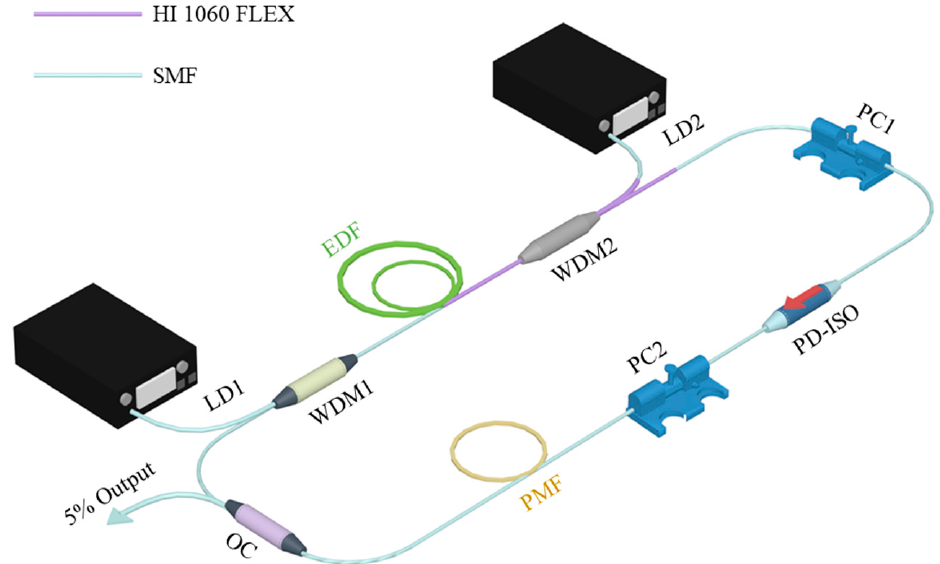
Figure 1. Experimental setup of HRR erbium-doped fiber laser. Due to the existence of PD-ISO and PMF, a wavelength-dependent birefringence- induced filter with a comb transmission spectrum is formed in the cavity [34,35]. This filter is also called a Lyot filter and its transmission function can be described as [36,37]